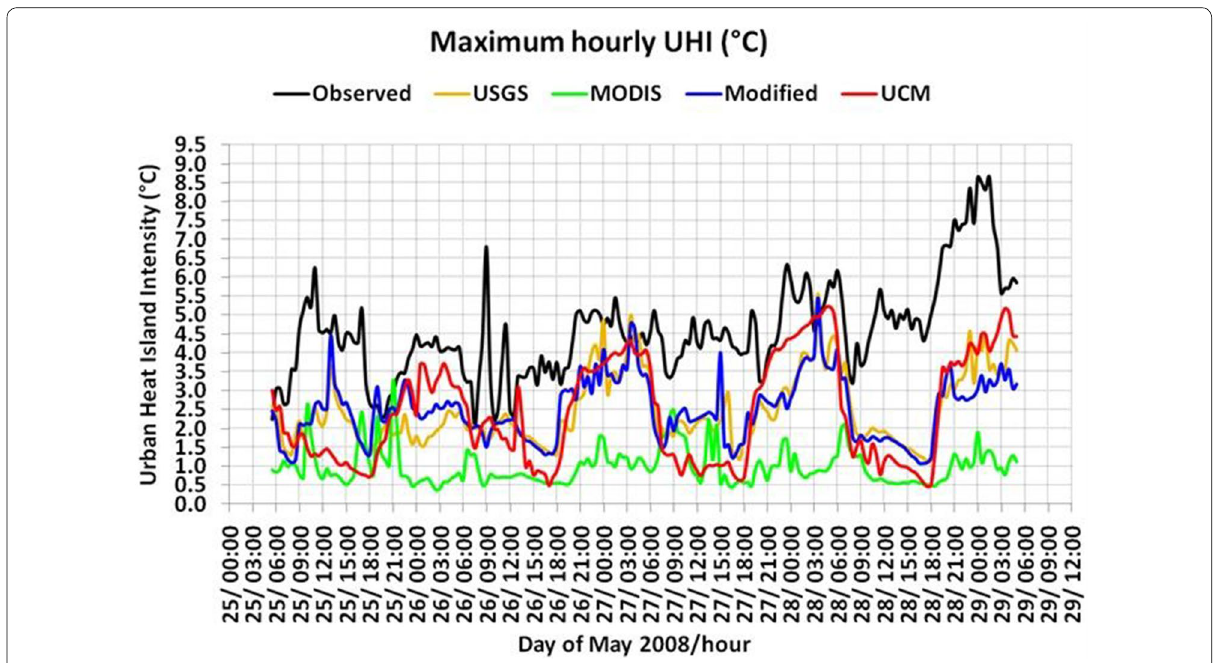
Fig. 7 Time series of hourly maximum UHI